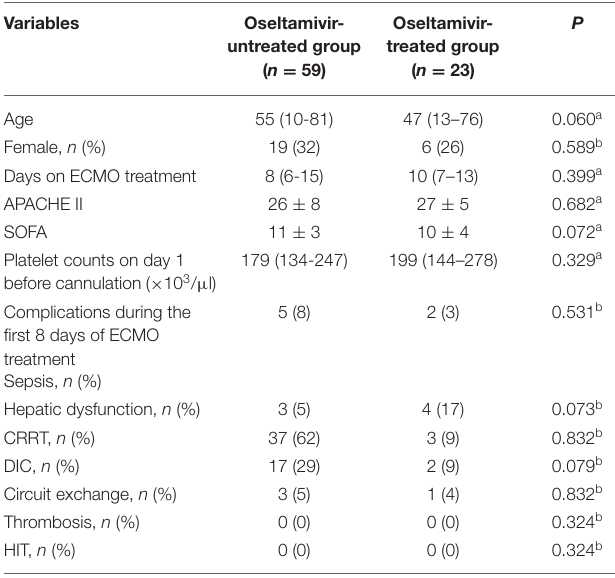
TABLE 1 | Characteristics of adults who received VA-ECMO for refractory cardiac failure ( n = 82).